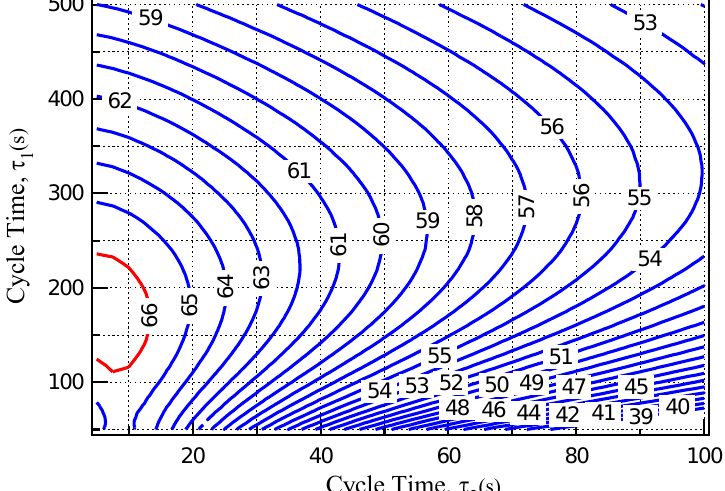
Figure 9. Contour plot of SCP relating to processing time τ temperature of former